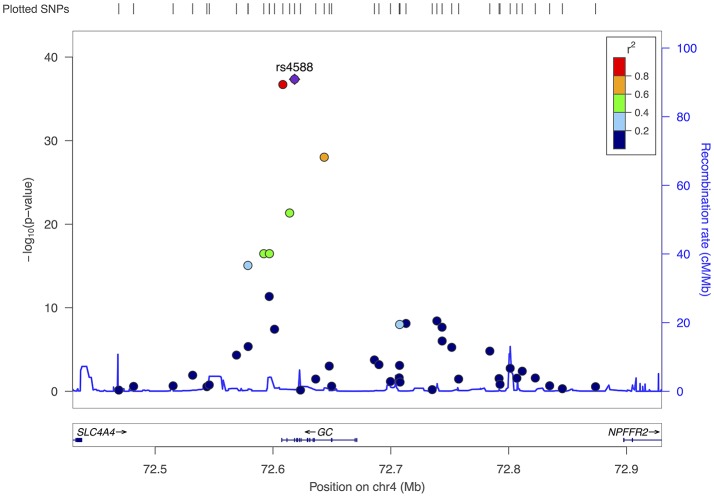
Fine-mapping of region surrounding rs4588 (chromosome 4), all participants.